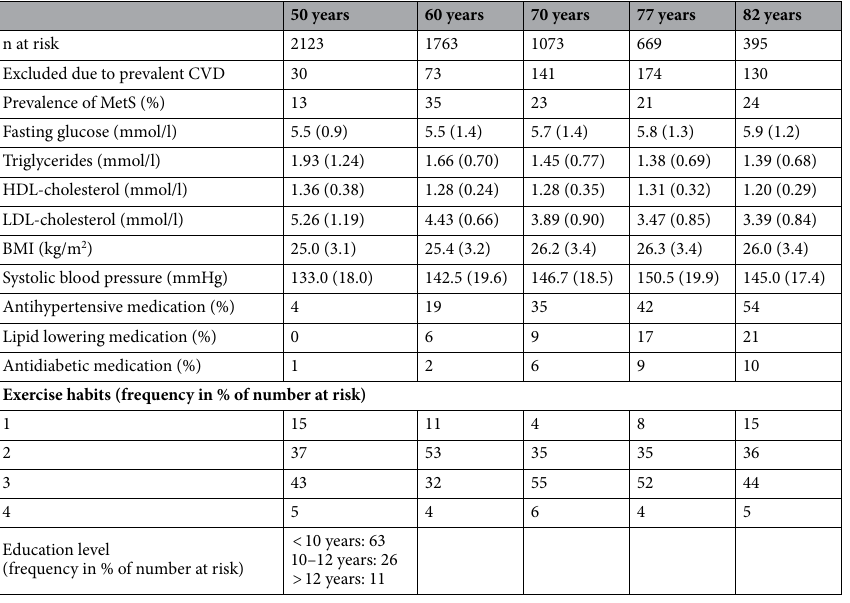
Table 1. Number of subjects at risk, number of individuals withdrawn from analysis due to prevalent cardiovascular disease (CVD) at the examination, prevalence of the metabolic syndrome (MetS), prevalent cardiovascular disease, cardiovascular risk factors and medications at the time of the different investigations. Definitions of the exercise habits groups: 1. Do you spend most of your time reading, watching TV, going to the cinema, or engaging in other, mostly sedentary activities? 2. Do you often go walking or cycling for pleasure? 3. Do you engage in any active recreational sports or heavy gardening at least 3 h every week? 4. Do you regularly engage in hard physical training or competitive sport? HDL, high-density lipoprotein; LDL, low- density lipoprotein; BMI, body mass